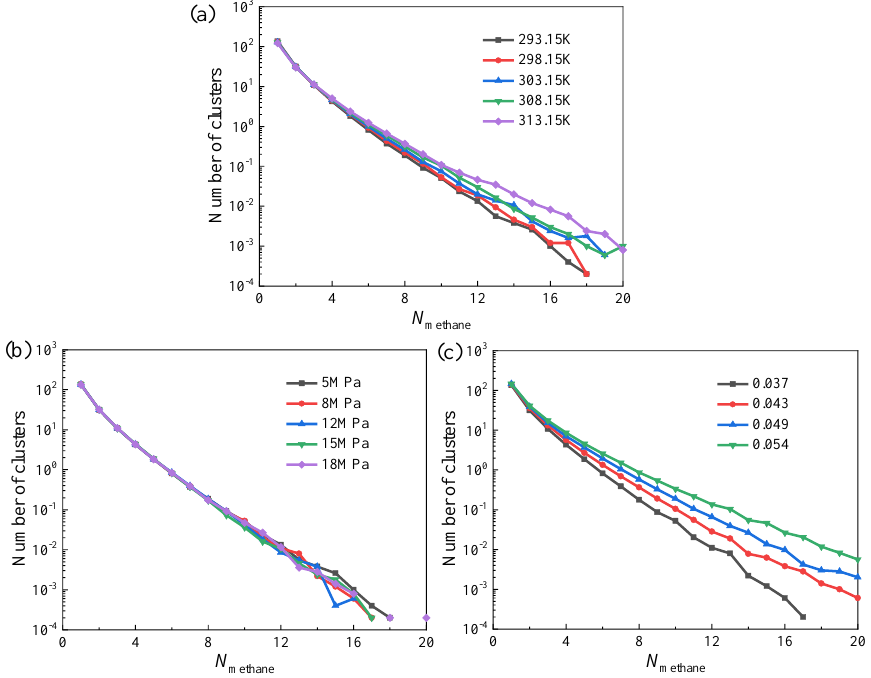
Figure 3. Time-averaged N methane distributions on methane clusters in ( a ) Sys1_5MPa at different temperatures, ( b ) Sys1 at 293.15 K and at different pressures, and ( c ) systems with different X methane values at 8 MPa and 293.15 K.